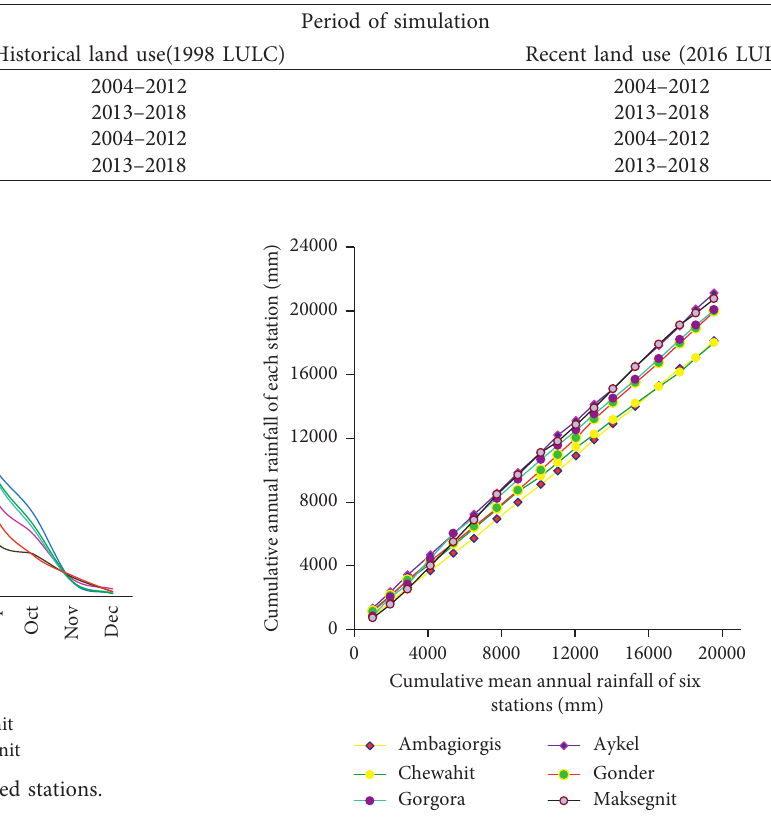
Figure 10: Double mass curve consistency test plot.